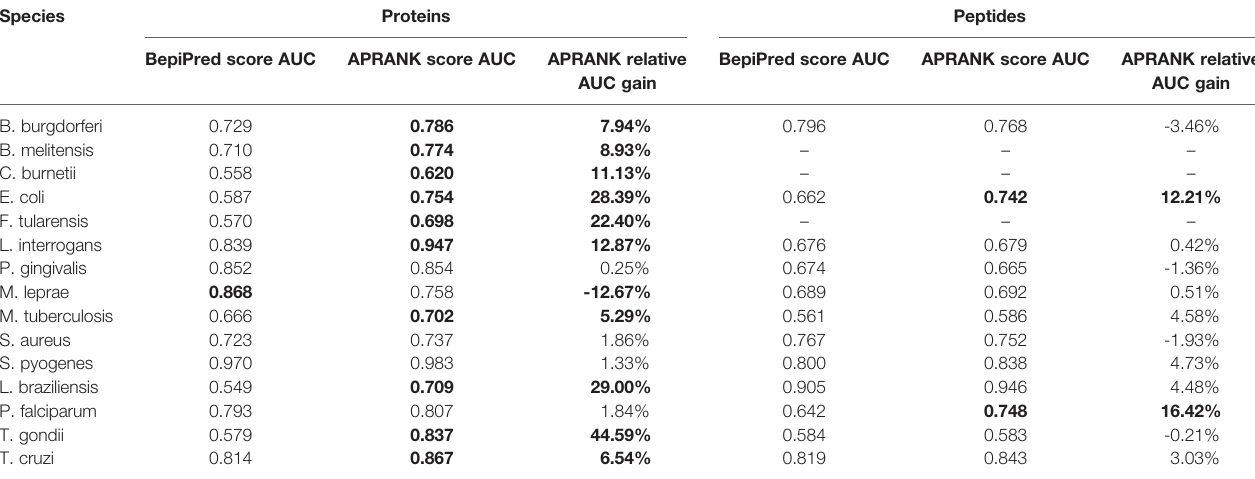
TABLE 6 | Comparison between APRANK and the predictor with highest solo AUC (BepiPred 1.0). Species Proteins BepiPred score AUC